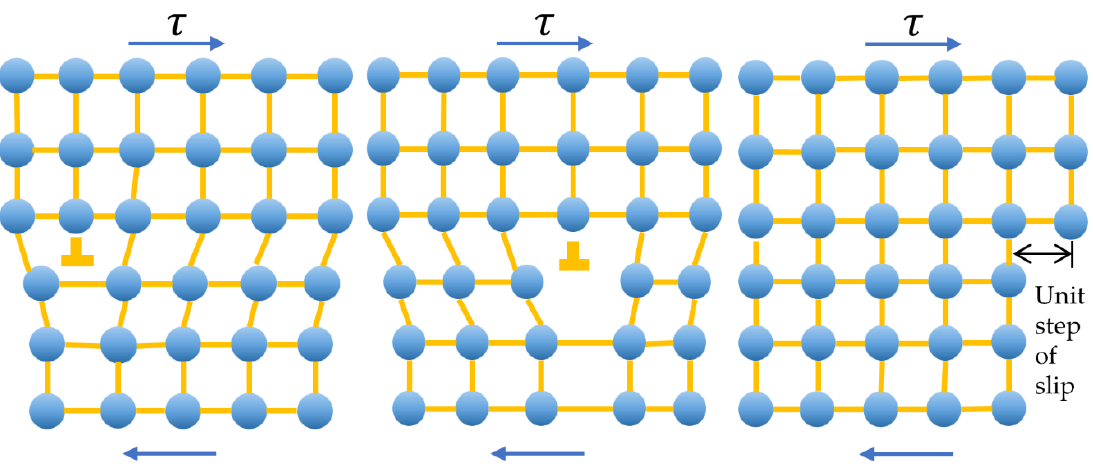
Figure 18. Dislocation from the perspective of a slip plane.